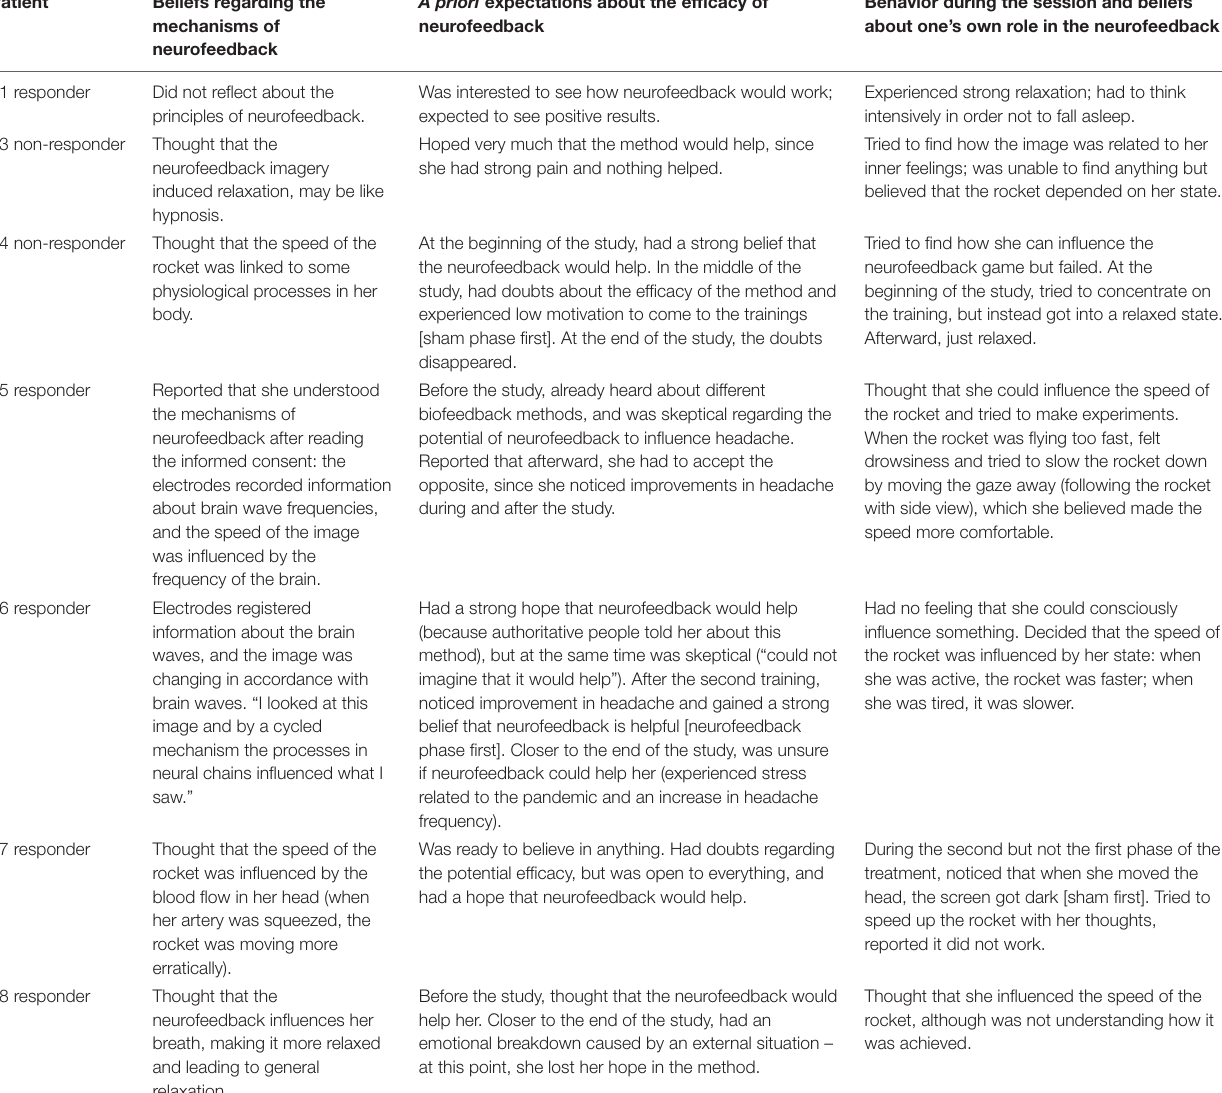
TABLE 3 | Results of the post-study interviews.